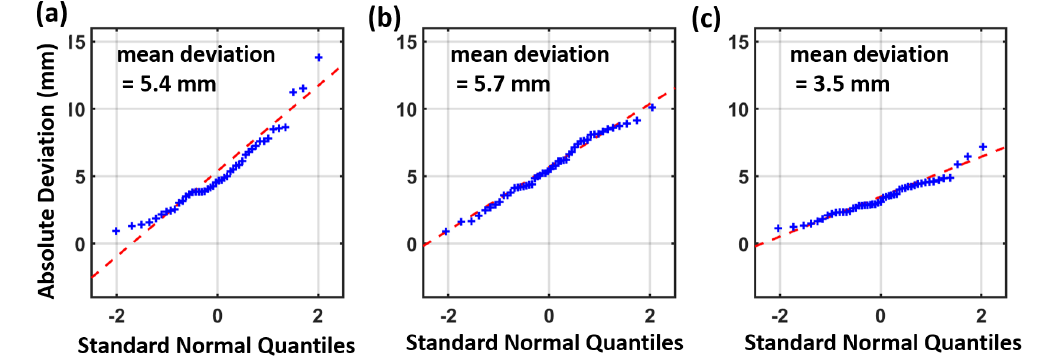
Figure 10. QQ-Plot with horizontal ( a ) with a single lighthouse, ( b ) with two lighthouses, and ( c ) with two lighthouses after bad tracking issues.